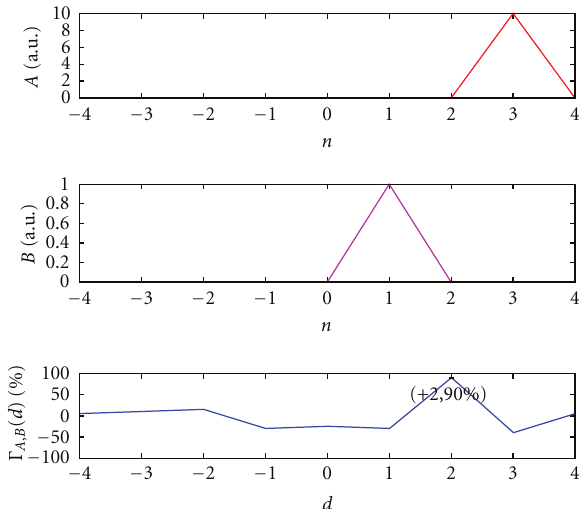
Figure 2: From top to bottom: one reference signal A , the same B but with a lower amplitude and delayed by two samples, and their normalized cross-correlation function Γ A , B ( d